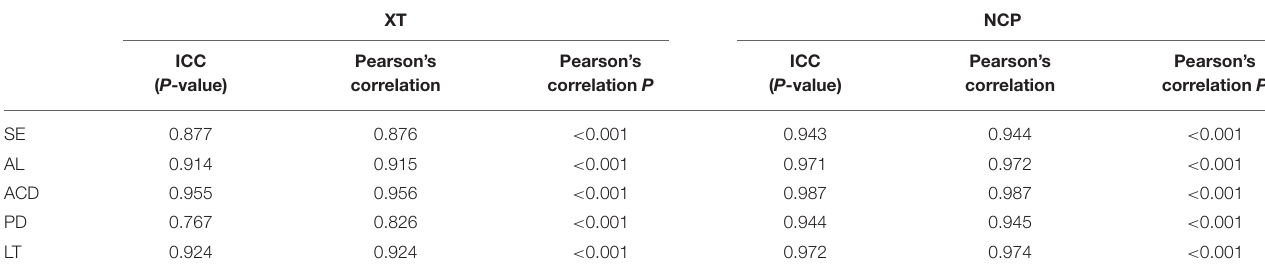
TABLE 2 | Correlation coefficients of the ocular biometric parameters between the two eyes within concomitant exotropia and control participants.